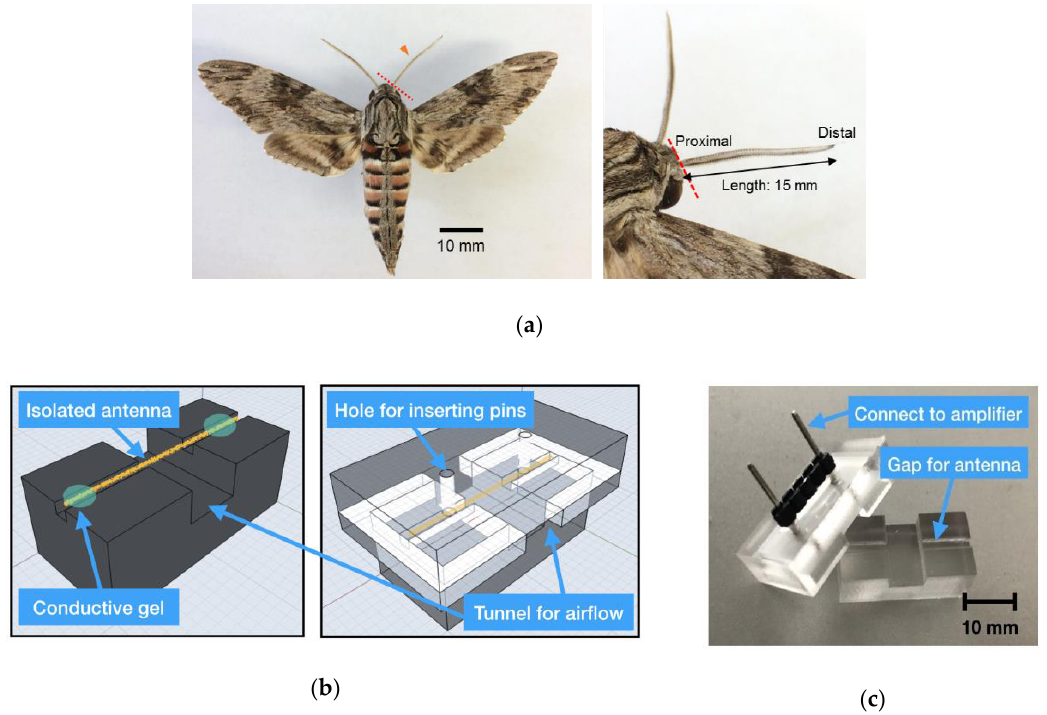
Figure 1. Hawkmoth antenna and antenna holder setup. ( a ) The antennae of the male hawkmoth, A. convolvuli . The antenna was cut at the base (red dashed line; the antenna is indicated by an arrowhead). The total length of the antenna was around 15 mm and its maximum diameter was about 1 mm. ( b ) Drawings of the antennal holder. The isolated antenna was placed on the lower part, electroconductive gel was added on both ends (left panel), the upper part covered the lower one (right panel), and then pins were inserted through two holes. The pins attached the proximal and distal ends of the antenna. ( c ) Appearance of the antennal